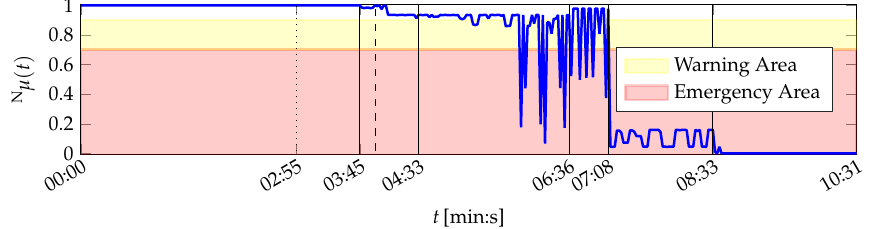
Figure 8. Evaluation of the system health N µ over time during manipulated operation of the printing unit demonstrator (PU manip ). The result depicted here is based on the attribute healths shown in Figure